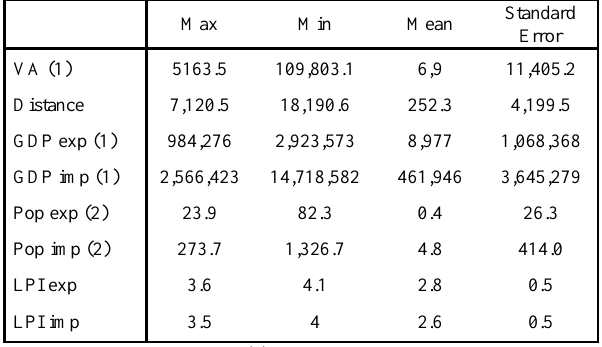
Table 3A: Main Statistics 2008 for Group 2